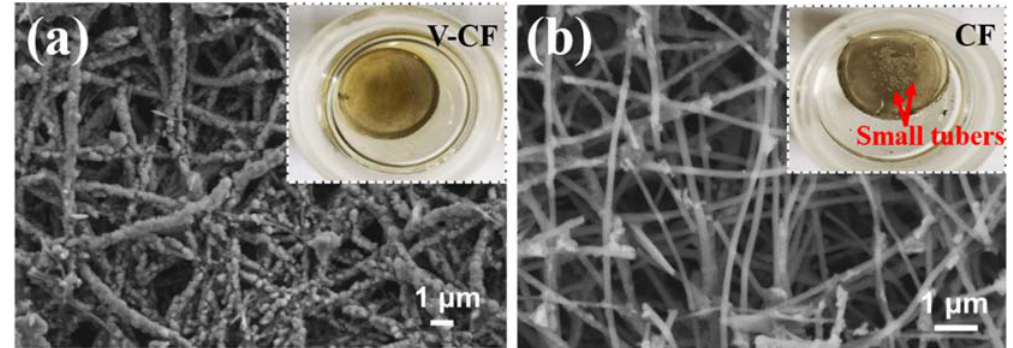
Figure 6. SEM of the V ‐ CF ( a ) and the CF ( b ) interlayers after 100 cycles. Insert in each figure shows the photographs of the corresponding lithium electrode after 100 cycles at 1 C. The metallic lithium electrodes for both samples are immediately immersed into a mixture of DOL and DME for photograph observation.